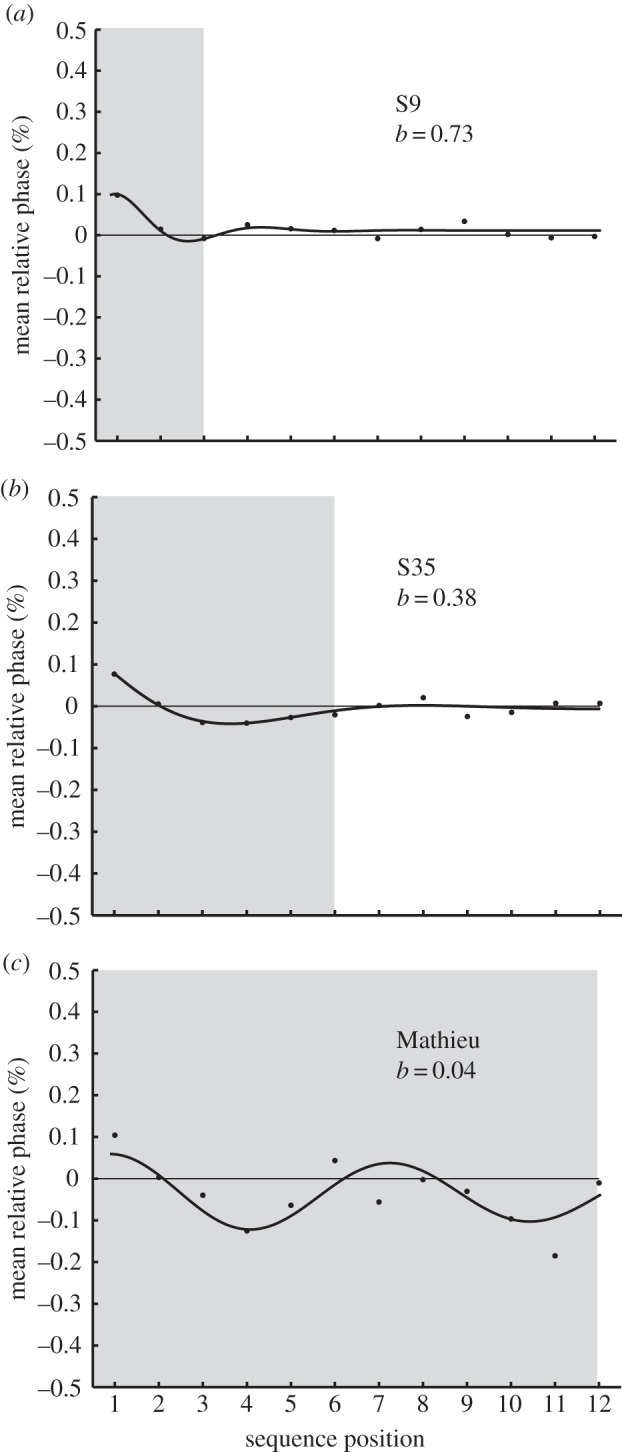
Model fits (line) to data (dots) from sample trials (8% phase perturbation) of control participants and Mathieu. Shaded region demonstrates relaxation parameter b for fast (a), moderate (b) and slow (c) adaptation.